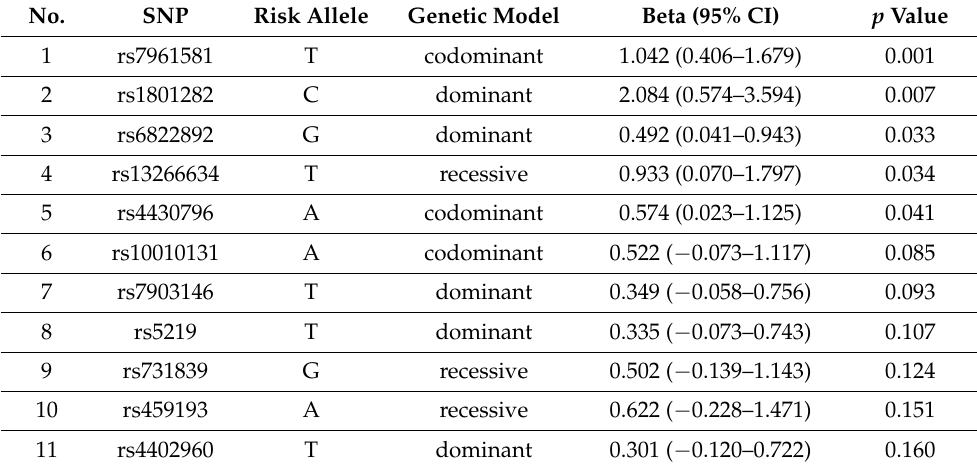
Table 2. The list of SNPs (coded by the most fitting genetic model of inheritance) ordered by the strength of their association (expressed by p value from the lowest to the highest) with HOMA—IR in the adjusted (for ethnicity, sex, age, BMI, and treatments) linear regression model. No.